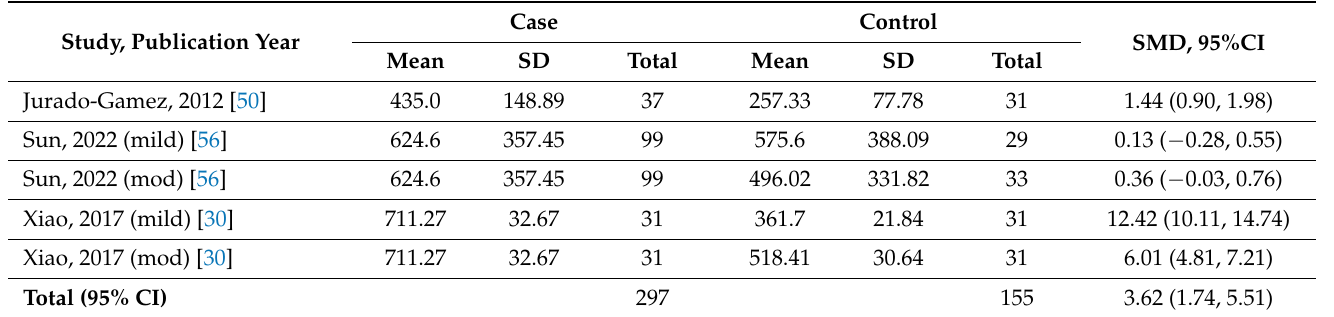
Table 3. Results of random-effects forest plot analysis. Serum/plasma intercellular adhesion molecule- 1 levels in adults with severe compared to mild/moderate obstructive sleep apnea.